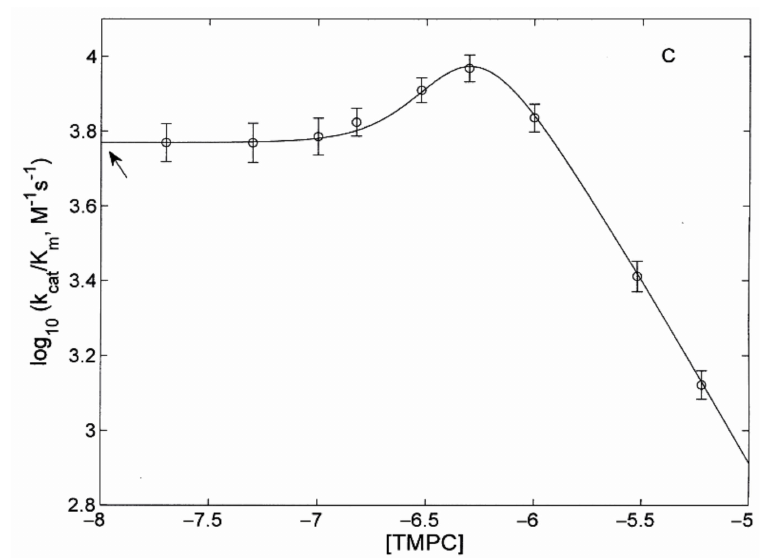
Figure 5. Dependence of k cat ( A ), K m ( B ), and k cat / K m ( C ) for h20S proteasome ChT-L activity on TMPC. Continuous lines are obtained by non-linear least-squares fitting of data according to Equation (3a–c), respectively, employing parameters reported in Table 1. Arrows indicate the values of catalytic parameters in the absence of TMPC and asterisks correspond to the measured values of k cat and K m